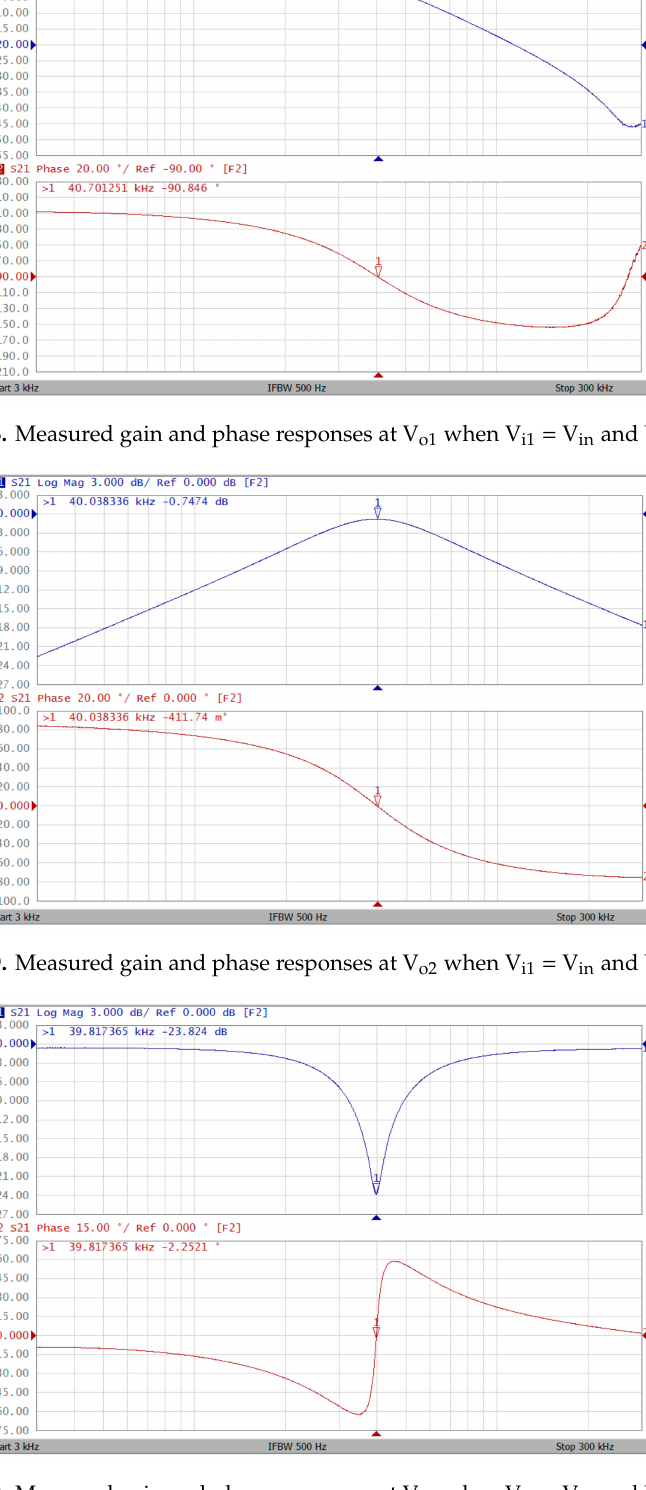
Figure 20. Measured gain and phase responses at V o3 when V i1 = V in and V i2 =